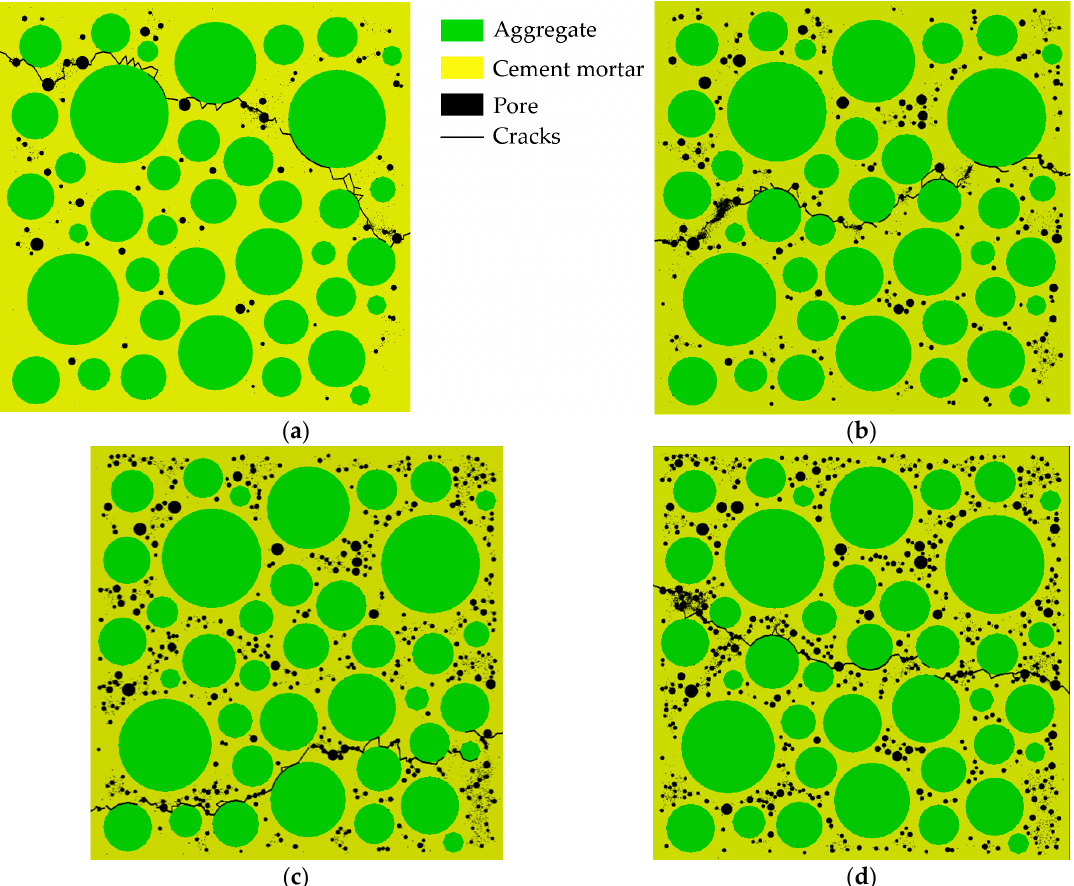
Figure 14. Distribution of macroscopic penetrating cracks. ( a ) 1-1-L (total porosity = 1%); ( b ) 2-1-L (total porosity = 2%); ( c ) 3-1-S (total porosity = 3%); ( d ) 4-1-L (total porosity = 4%).